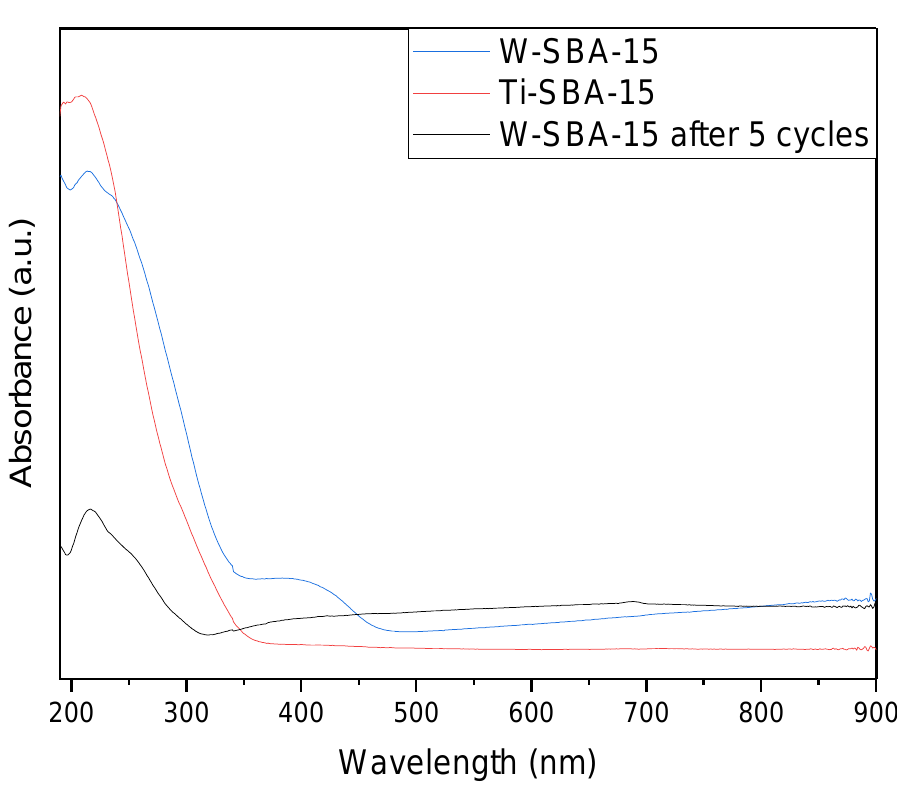
Figure 5. Diffuse reflectance UV-Vis spectra of the catalysts.